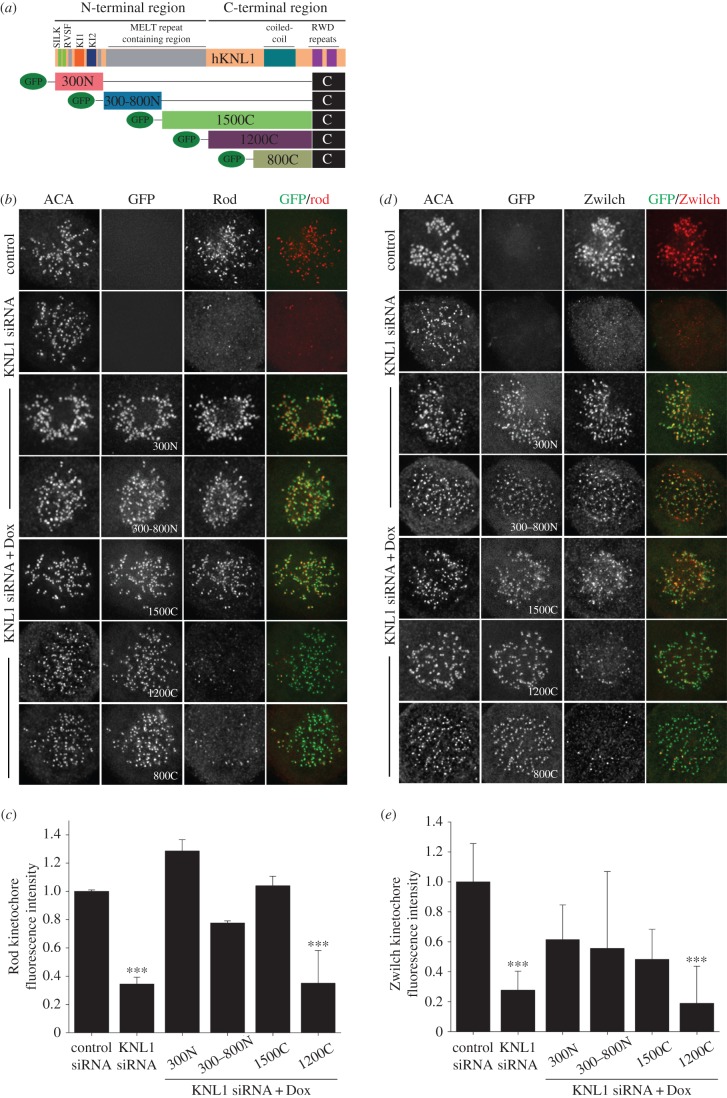
KNL-1 N-terminus is required for RZZ kinetochore localization. (a) Schematic of GFP-KNL1 constructs stably incorporated into Flp-In T-REx HeLa cell lines [15]; the amino acids of KNL1 constructs shown are as follows: amino acids 1–300 (300N), 300–818 (300–800N), 1174–2316 (1200C) 1519–2316 (800C), 819–2316 (1500C), 2056–2316. (b,d) Flp-In T-REx HeLa cells were depleted of endogenous KNL1, rescued with the indicated GFP-KNL1 fragment upon doxycycline addition and immunostained with the indicated antibody. (c,e) Kinetochore fluorescence intensities were measured in control cells, KNL1-depleted cells and GFP-KNL1 Flp-In T-REx cells treated with KNL1 siRNA and doxycycline. Error bars represent s.e.m. (c) n > 720 kinetochores, n > 12 cells per condition and n = 2 independent experiments. (e) n > 240 kinetochores and n > 4 cells per condition. (c,e) ***p < 0.001 (Mann–Whitney rank sum test).